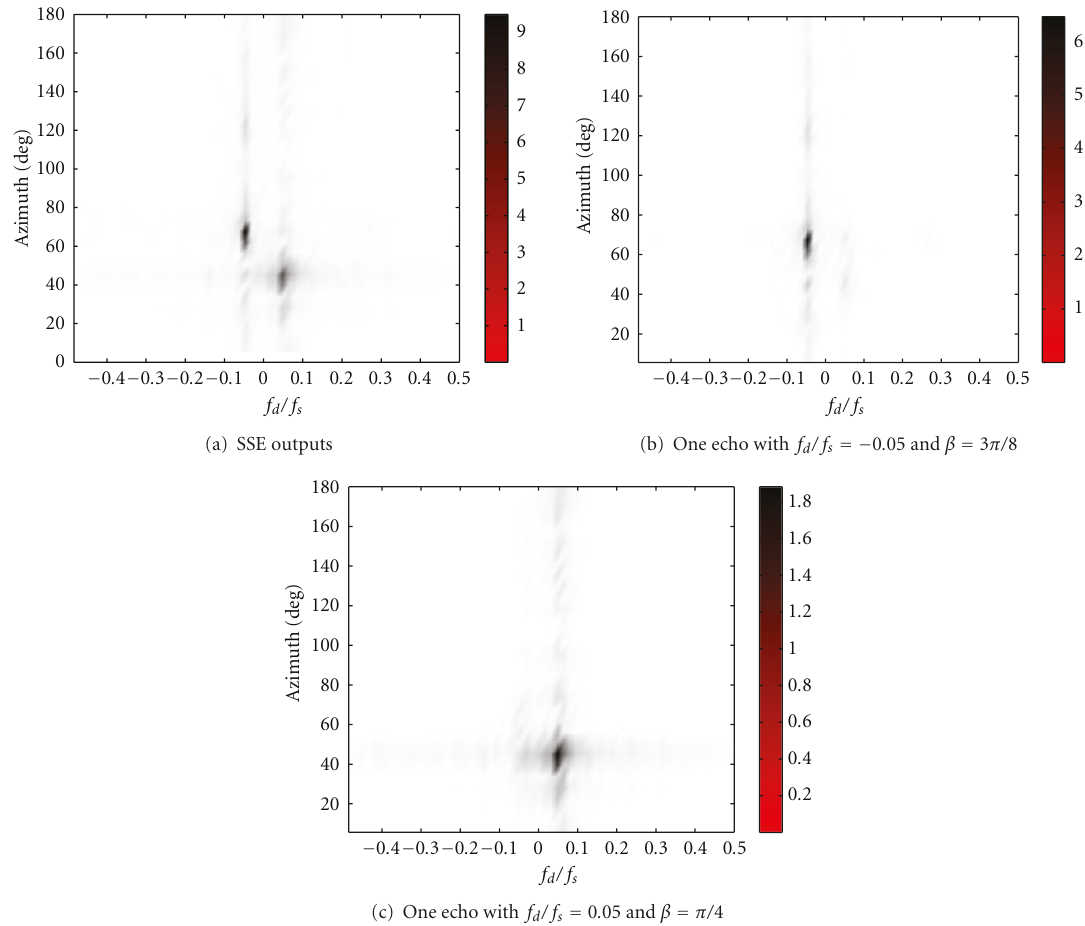
Figure 5: Separation performance via SSE with signal power ratio 1:0.97.